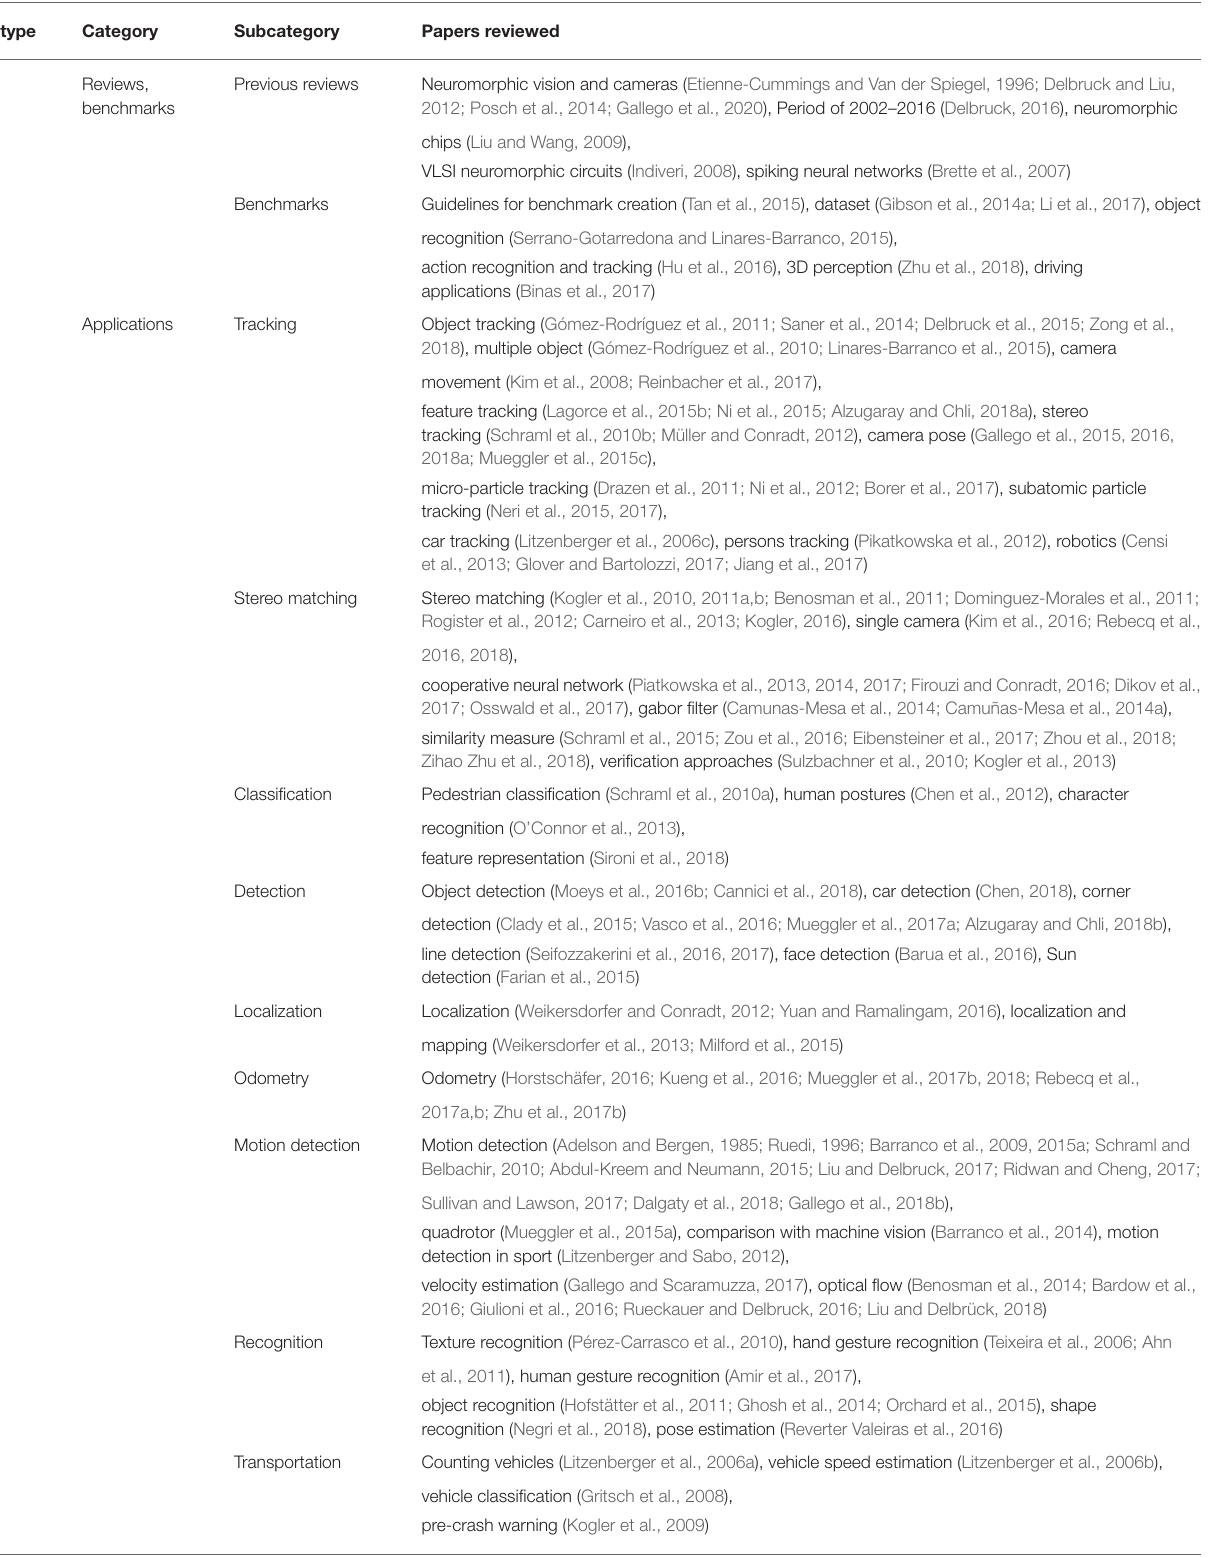
TABLE 1 | The paper structure. Sensor